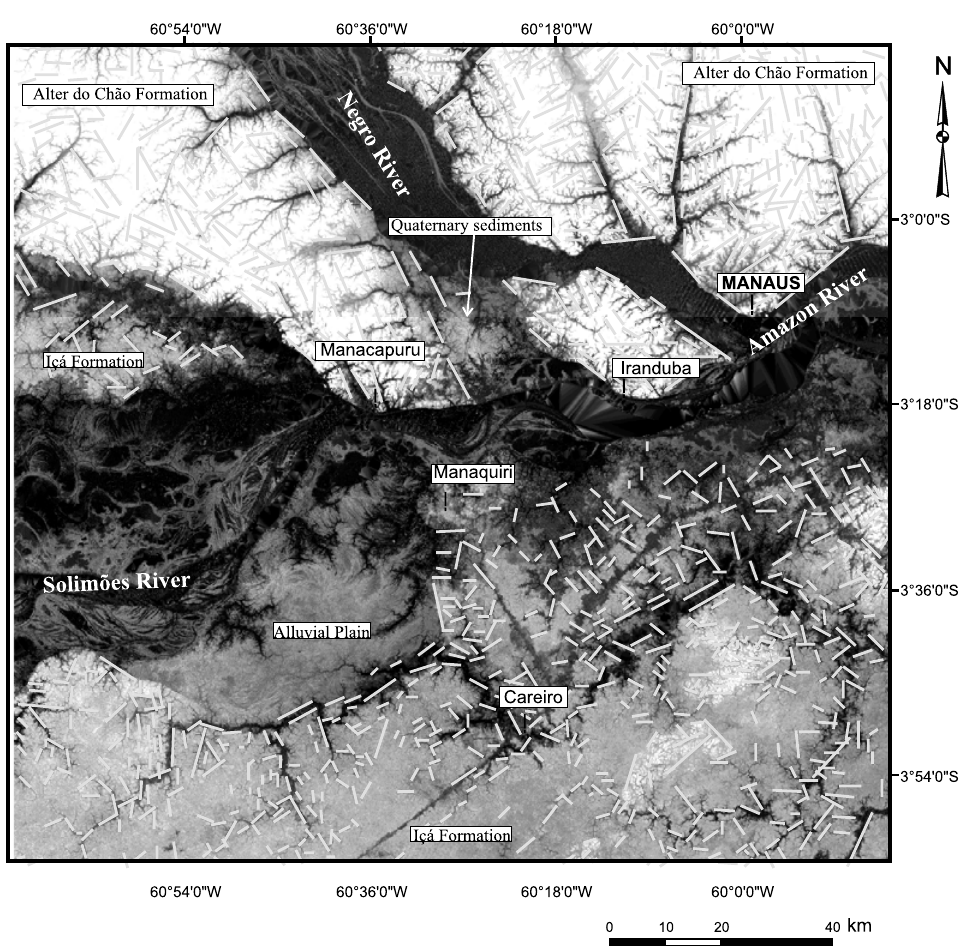
Fig. 7 – Relief lineaments overlayed to the SRTM